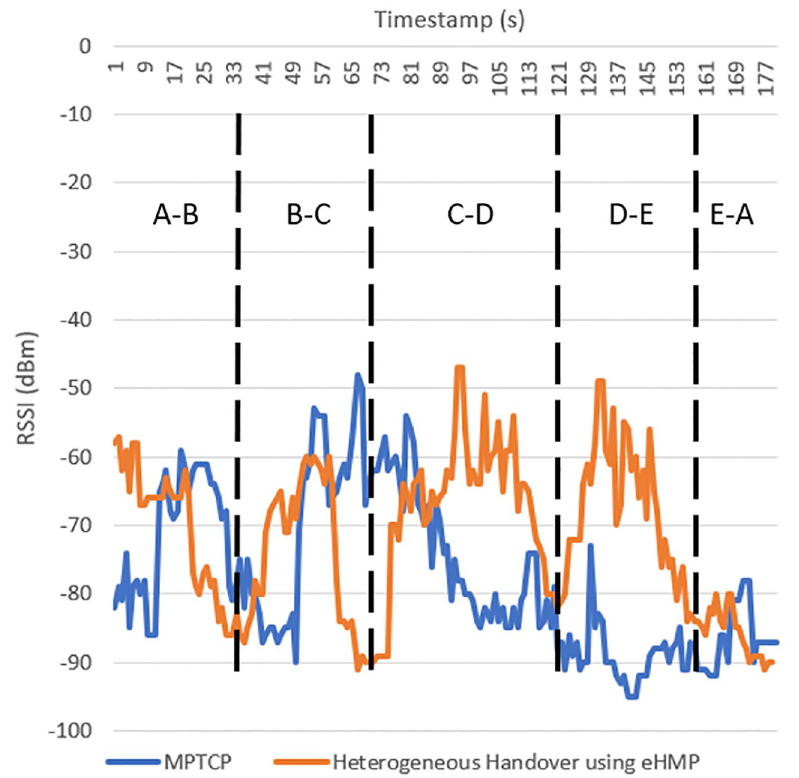
Fig 30. RSSI of connected WiFi AP in MPTCP and heterogeneous handover using eHMP.